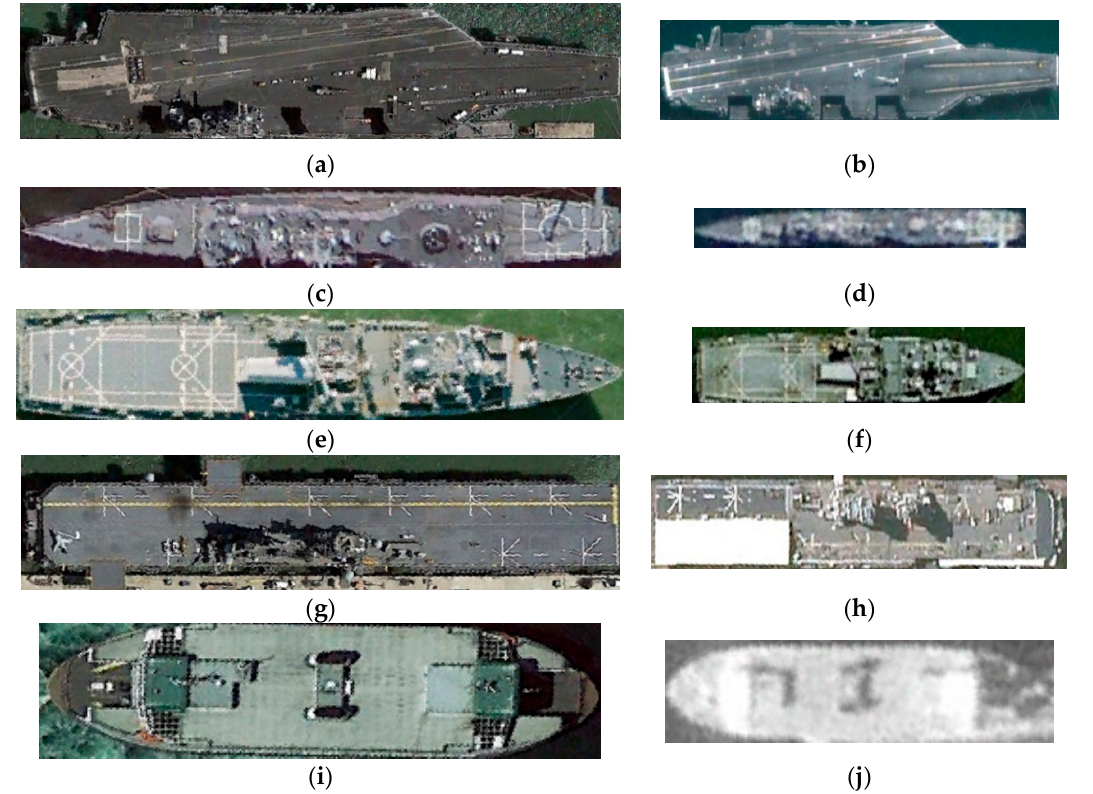
Figure 3. Representative samples from dataset 2. ( a ) Ship with type 1 from target domain. ( b ) Ship with type 1 from source domain. ( c ) Ship with type 2 from target domain. ( d ) Ship with type 2 from source domain. ( e ) Ship with type 3 from target domain. ( f ) Ship with type 3 from source domain. ( g ) Ship with type 4 from target domain. ( h ) Ship with type 4 from source domain. ( i ) Ship with type 5 from target domain. ( j ) Ship with type 5 from source domain.